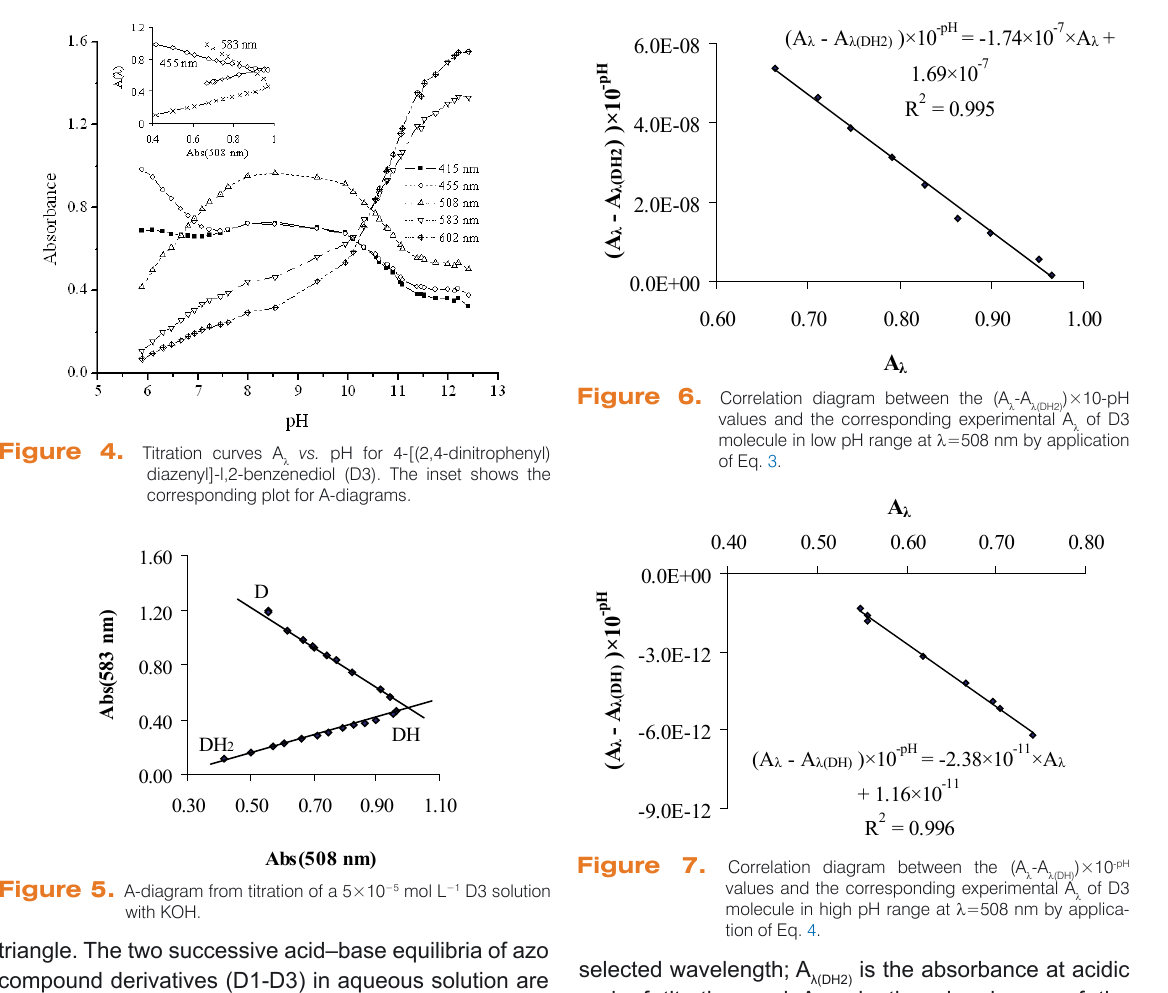
Figure 5. A-diagram from titration of a 5×10 −5 mol L −1 D3 solution with KOH.